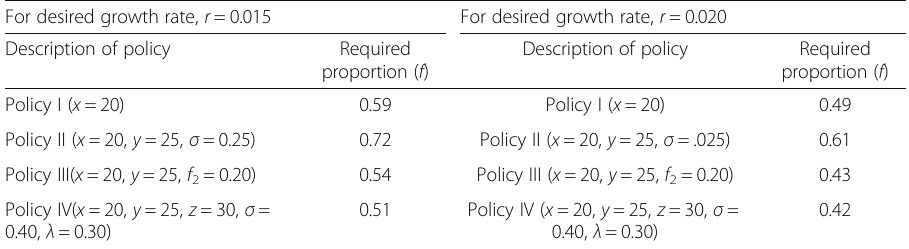
Table 3 Parameters and required proportion of contraceptive users at age 20 For desired growth rate, r = 0.015 For desired growth rate, r = 0.020 Description of policy Required Description of policy Required proportion ( f ) proportion ( f ) Policy I ( x = 20) 0.59 Policy I ( x = 20) 0.49 Policy II ( x = 20, y = 25, σ = 0.25)